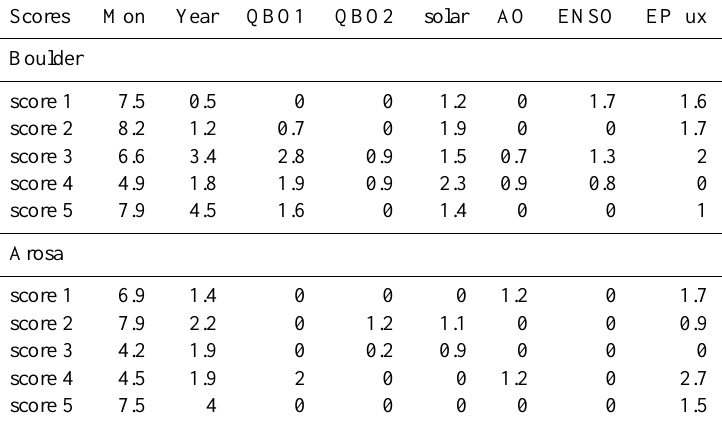
Table 1. Estimated EDFs of each covariate on ozone scores. EDF indicates the influence and level of linearity of a covariate: EDF = 1means linear relation; EDF = 0 implies non-significance; EDF > 1 means (possibly) nonlinear significance. Scores